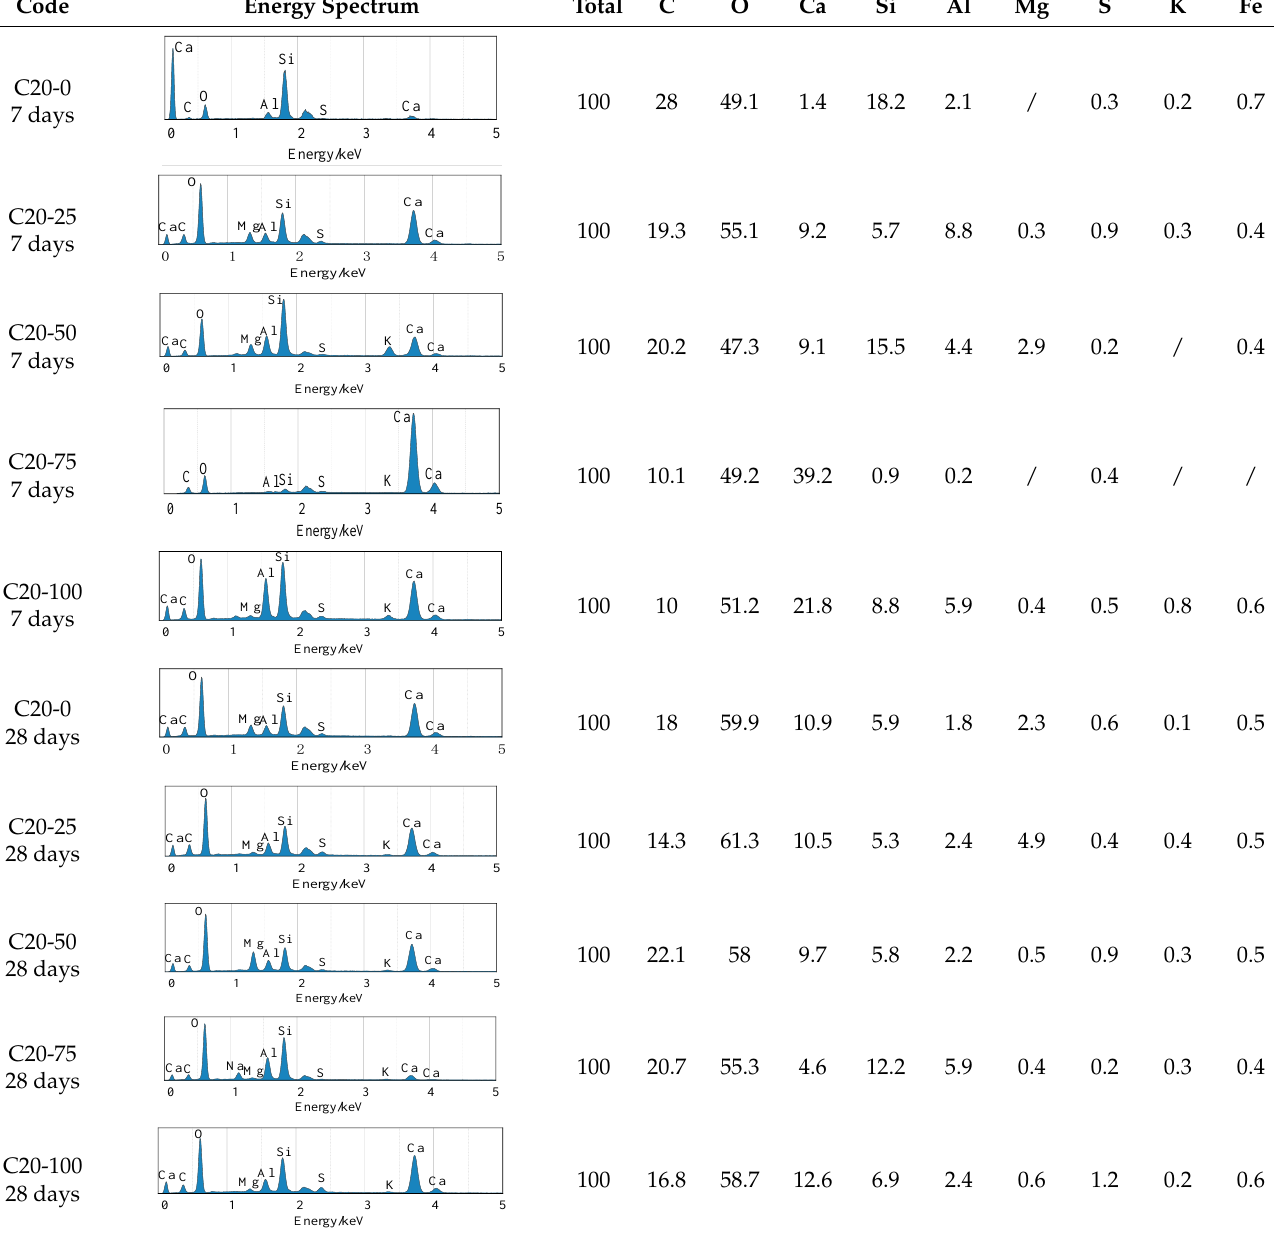
Table 7. Element analysis of C20 concrete (atomic fraction)/at %.